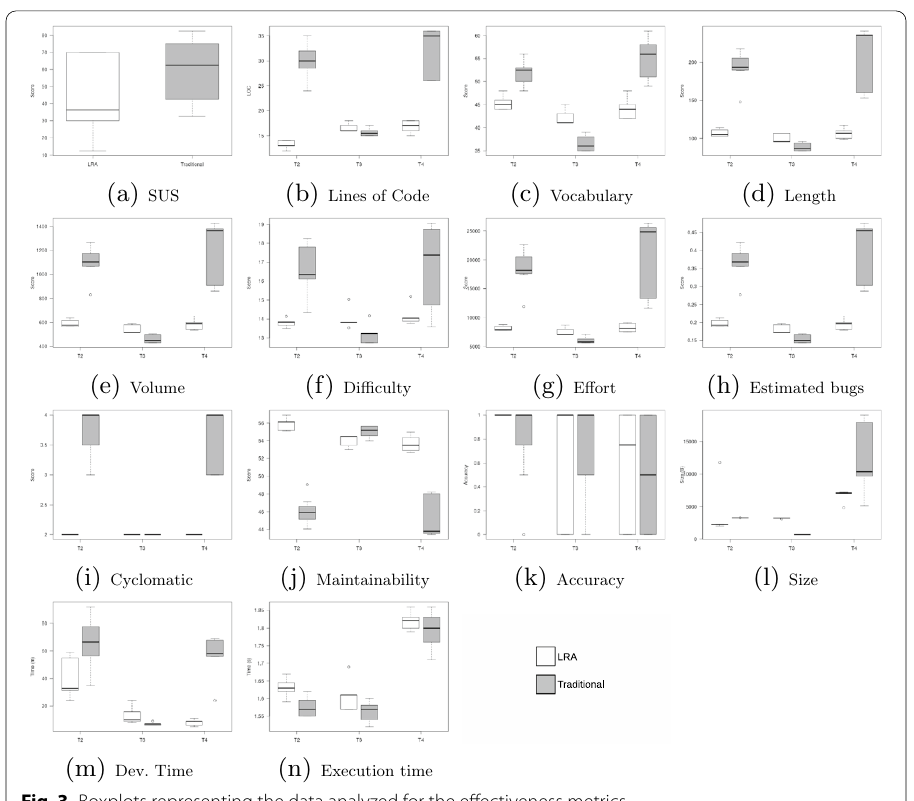
Fig. 3 Boxplots representing the data analyzed for the effectiveness